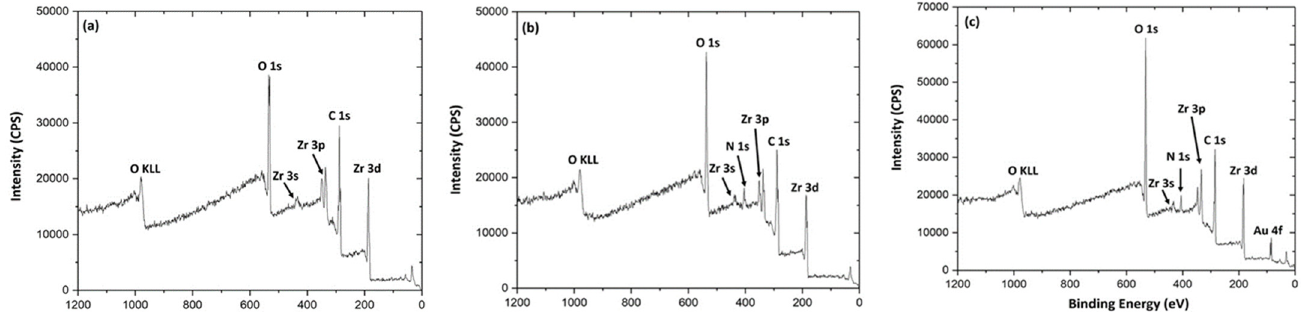
Figure 5. X-ray photoelectron spectra of ( a ) UiO-66-H, ( b ) UiO-66-NH 2 and ( c ) UiO-66-NO 2